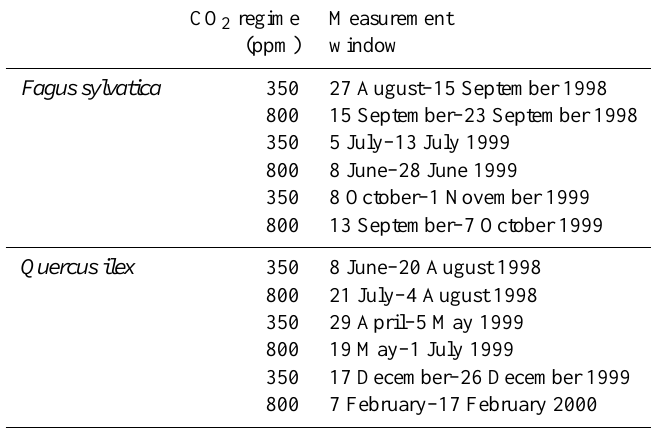
Table 1. Schedule of measurements of trees grown constantly under the indicated CO 2 regimes beginning in March 1998. Three individuals of each tree species in each growth regime were consecutively